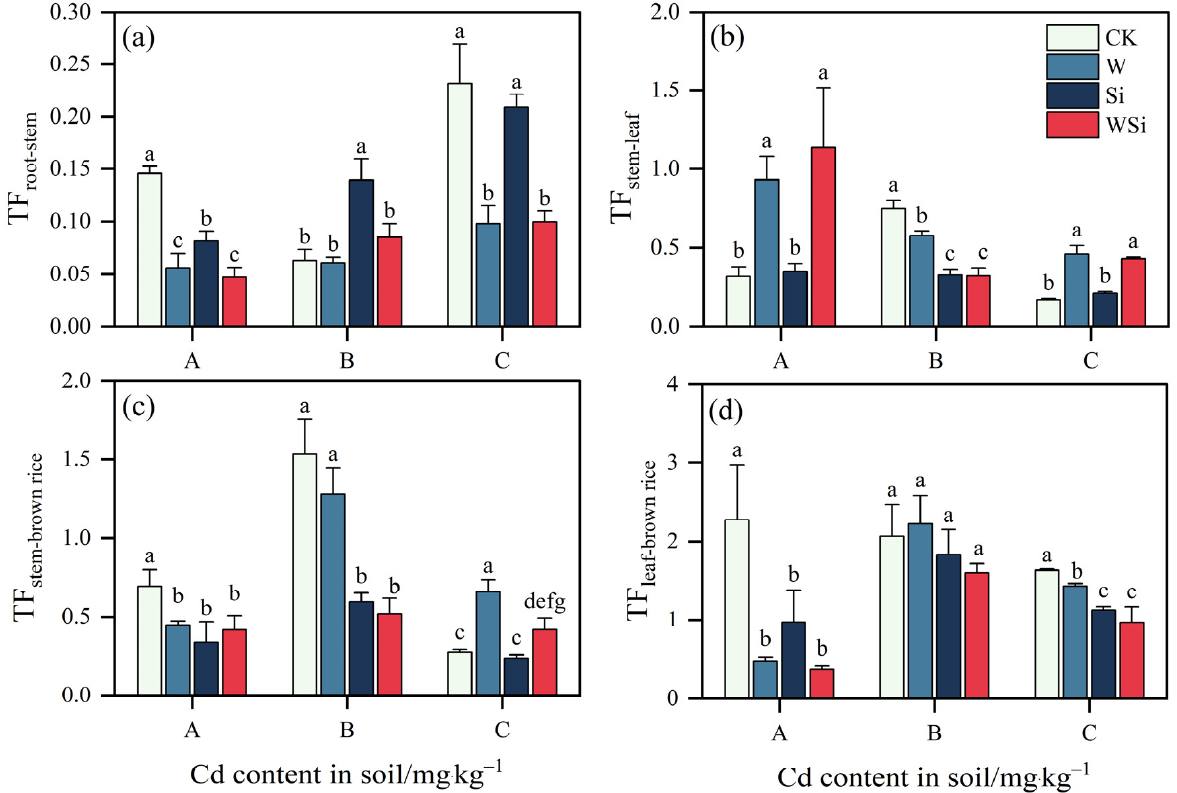
Figure 2. Synergistic effects of water management and silicon foliar spraying on the Cd translocation factor of rice organs (( a ) TF root–stem ; ( b ) TF stem–leaf ; ( c ) TF stem–brown rice ; ( d ) TF leaf–brown rice ). The error bar represents three repeated standard deviations (SDs). There is no significant difference between values with the same letters in the table ( p ≥ 0.05, Fisher’s LSD test). A, B and C represent the actual measured Cd content in soil after the addition of exogenous Cd at 0.20 mg · kg − 1 , 0.60 mg·kg − 1 and 1.60 mg·kg − 1 , respectively.